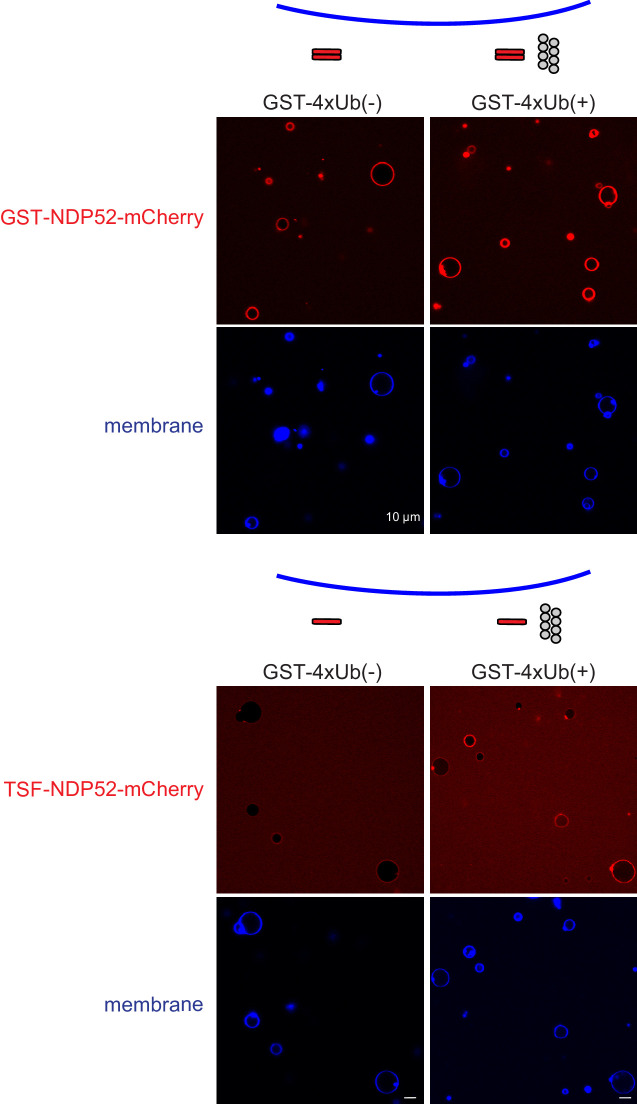
Membrane binding of NDP52.Representative confocal micrographs showing the membrane recruitment of NDP52. GST-NDP52-mCherry (upper) or TSF-NDP52-mCherry (lower) was mixed with GUVs in the presence or absence of GST-4xUb at room temperature. Images taken at 30 min were shown. Scale bars, 10 µm.